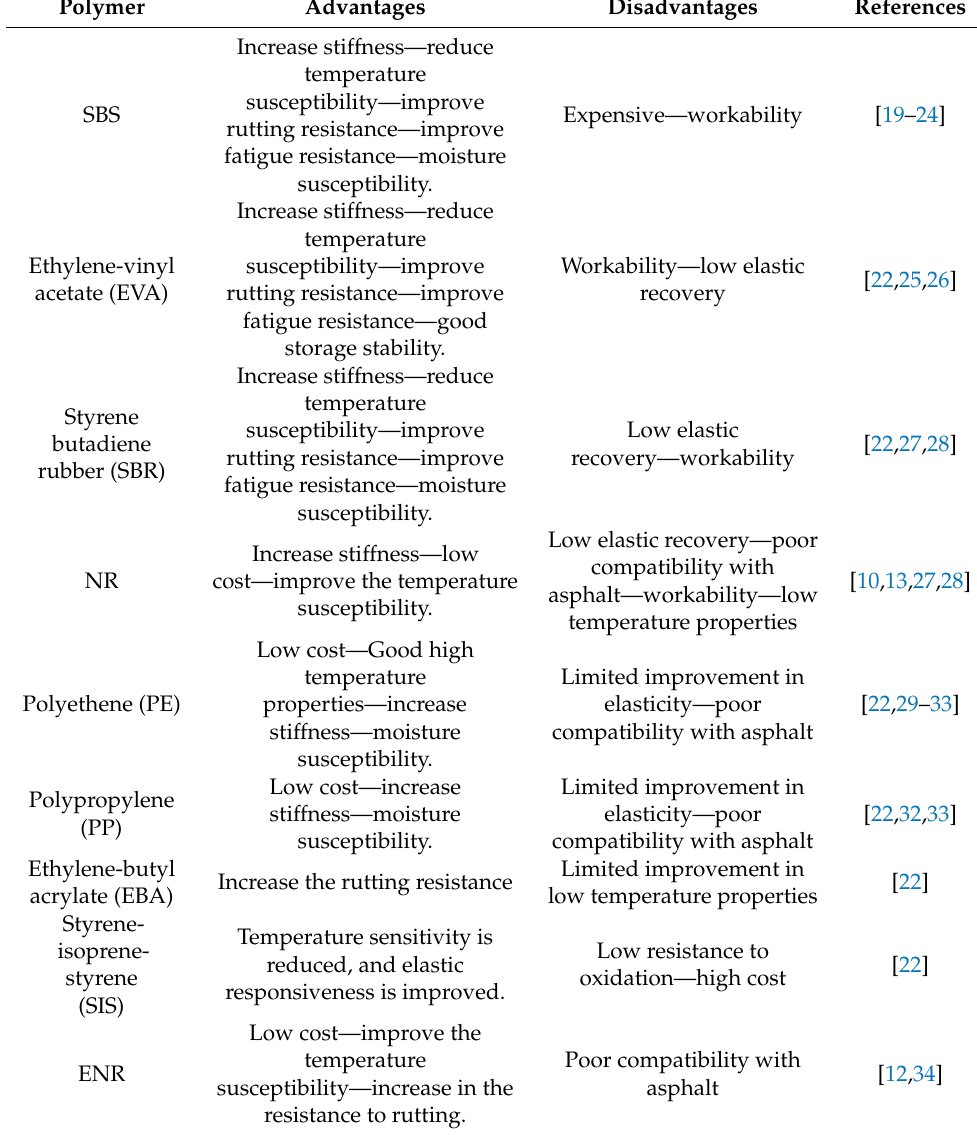
Table 1. Popular polymers for modification of